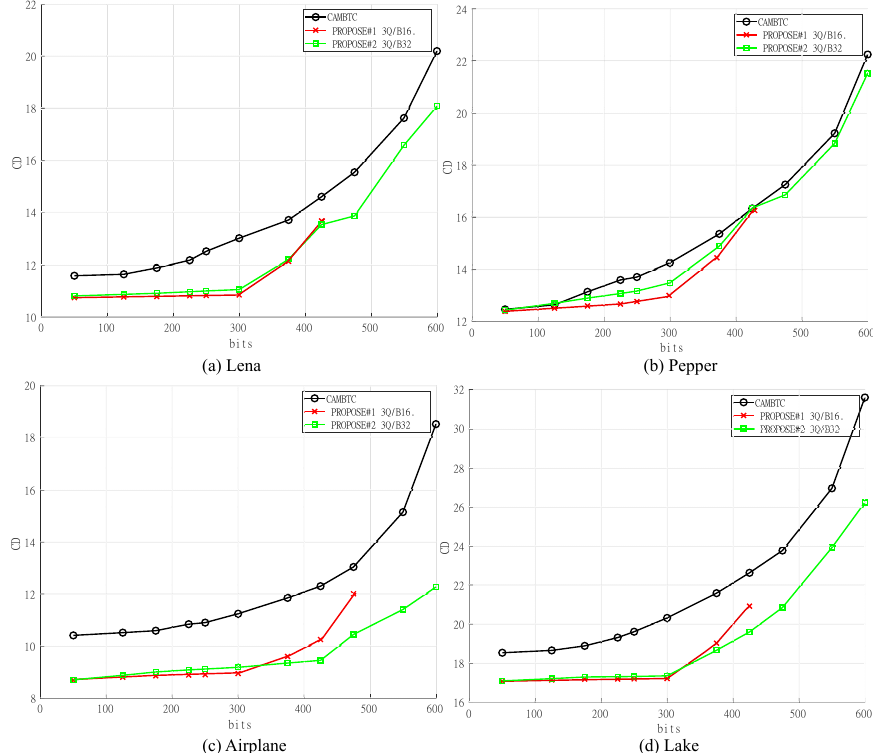
Figure 8. CD comparison according to EC.